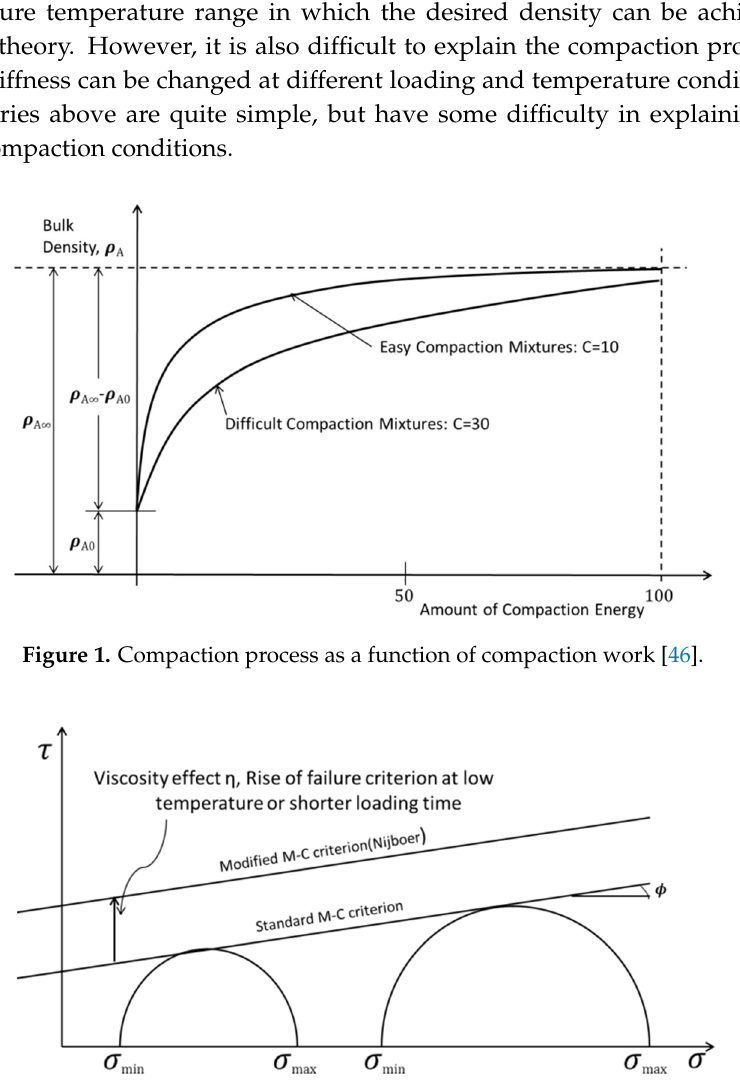
Figure 2. Mohr–Coulomb failure on the effect of temperature.